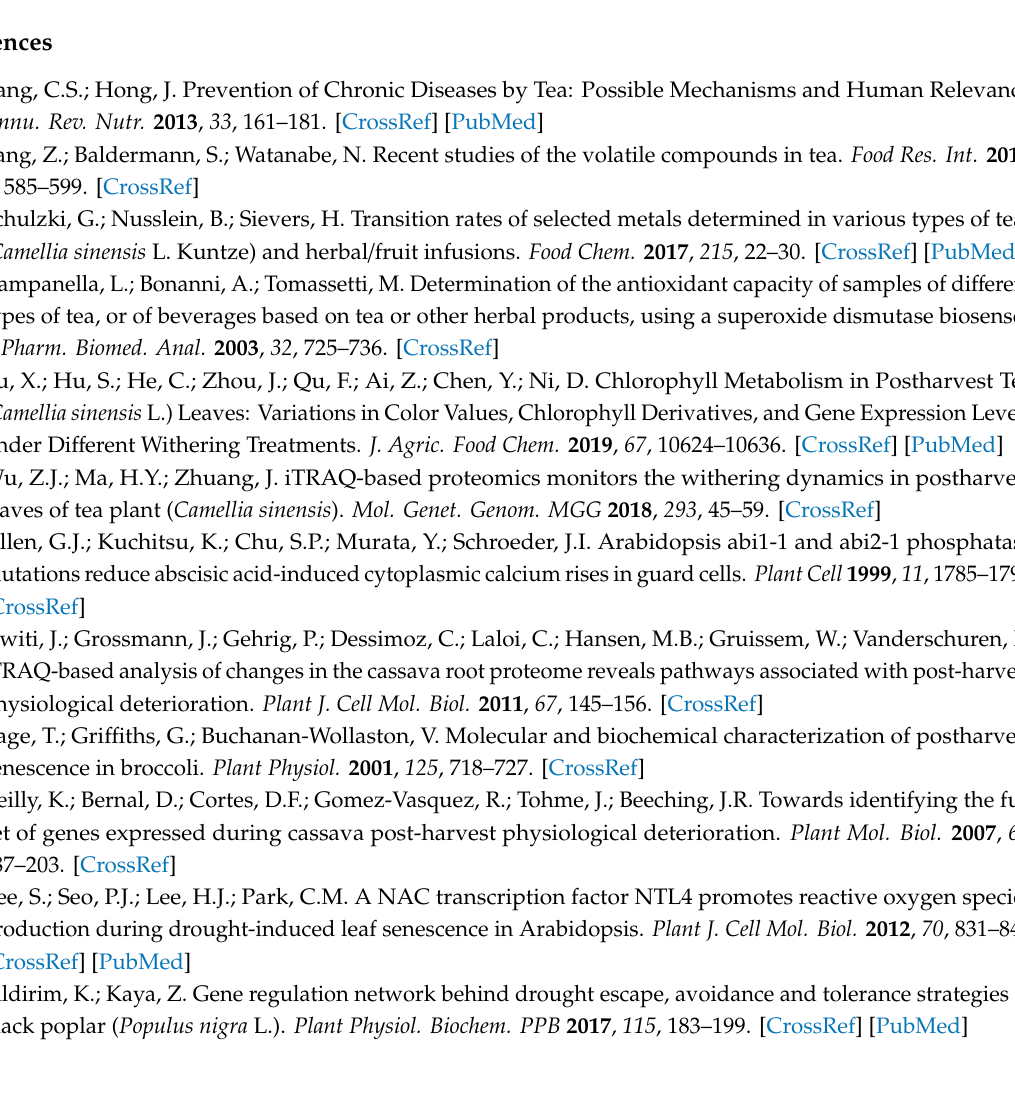
Supplementary Materials: Supplementary materials can be found at http: // www.mdpi.com / 2223-7747 / 9 / 2 / 204 / s1. Figure S1: Changes in the amounts of catechins (C, GC, EC, EGC, GCG, EGCG, ECG, and CG). Labeled points (not connected by the same letter) are significantly di ff erent at p values < 0.05, according to Duncan’s test. C, catechin; CG, catechin gallate; EC, epicatechin; ECG, epicatechin gallate; EGC, epigallocatechin; GC, gallocatechin; GCG, gallocatechin gallate; ECGC, epigallocatechin gallate. Figure S2: Changes in the content of ca ff eine and theanine. Labeled points (not connected by the same letter) are significantly di ff erent at p values < 0.05 according to Duncan’s test. Figure S3: Pearson correlation coe ffi cient between hormones (SA, JA, and ABA) and critical components (catechins, theanine, and ca ff eine). Figure S4: Co-expression network analysis. WGCNA analysis of co-expressed genes and critical components. Each row corresponds to a module. The color and number of each cell at the row–column intersection indicates the correlation coe ffi cient between the module and metabolites. A high degree of correlation between a specific module and the tissue type is indicated in red. Figure S5: Validation of the expression of candidate genes by qRT-PCR. Gene expression levels were determined by qRT-PCR and are presented as mean ± SD values, calculated by the 2 ∆∆ Ct method. Table S1: Statistics of the transcriptome data. Table S2: Expressed profiles and descriptions of all known genes. Table S3: Di ff erentially expressed genes (DEGs) in the comparisons, W2 vs. W1, W3 vs. W1, and W4 vs. W1. Table S4: KEGG enrichment analysis of DEGs in W2 vs. W1, W3 vs. W1, and W4 vs. W1. Table S5: KEGG analysis of co-expressed genes in each high correlation module. Table S6: Details of the genes selected for validating the reliability of the RNA-seq data by qRT-PCR. Author Contributions: Conceptualization, P.X. and Y.W.; Data curation, H.S.; Formal analysis, S.Z., R.J., and